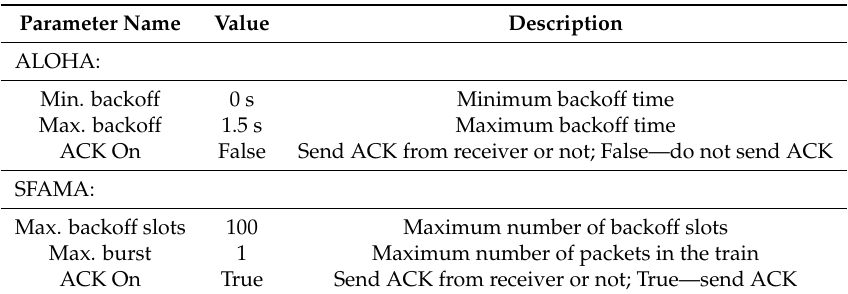
Table 1. ALOHA and SFAMA